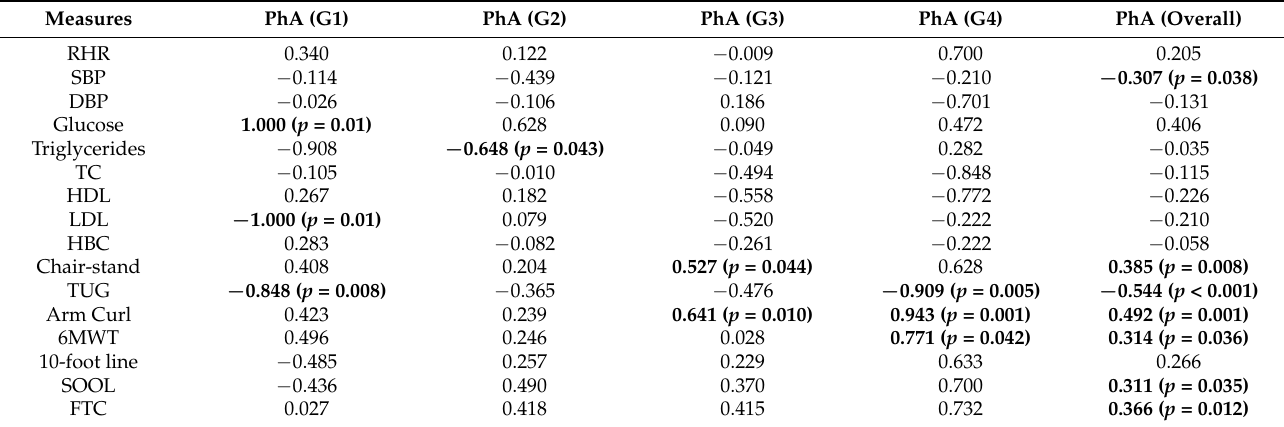
Table 3. Correlation analysis between PhA with hemodynamic, blood and functional tests for each group and overall